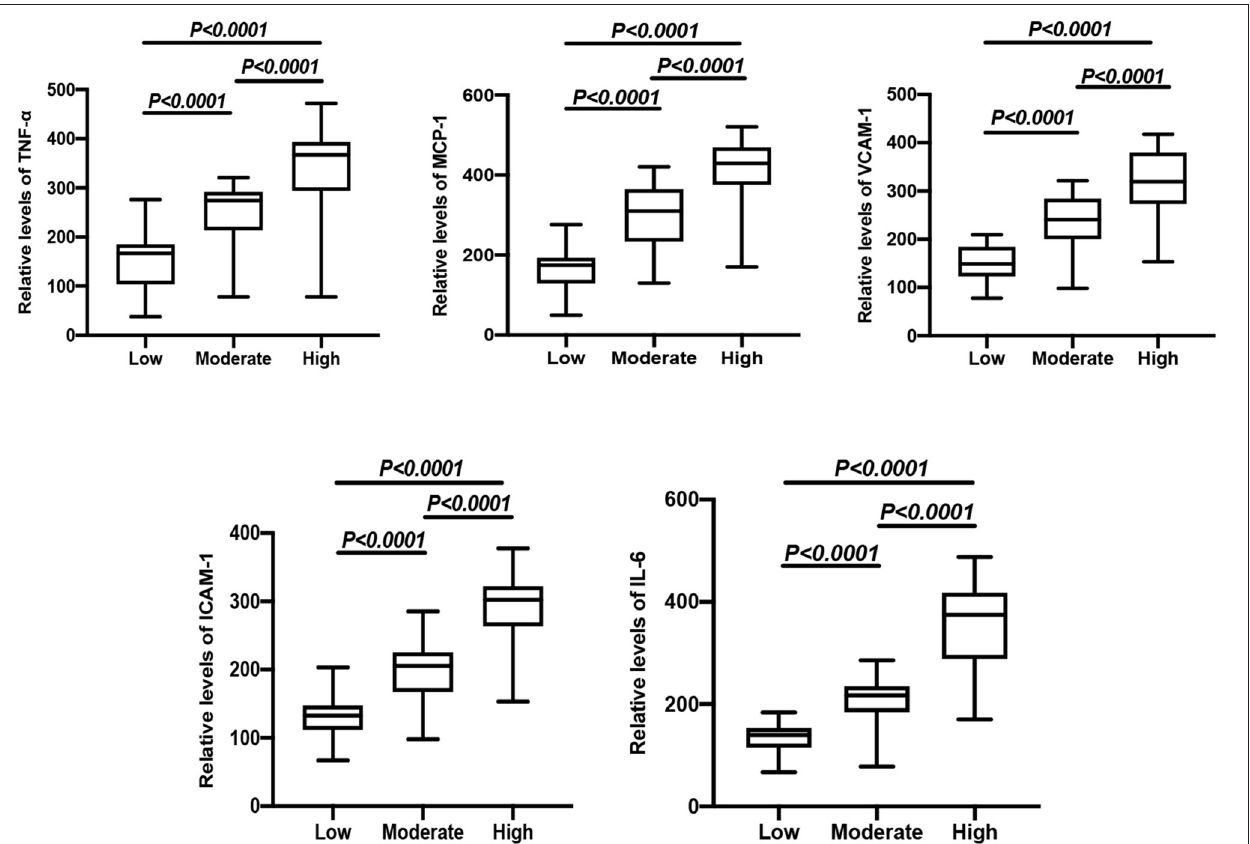
FIGURE 1 | Comparison of relative expressions of TNF- α , MCP-1, VCAM-1, ICAM-1, and IL-6 in the high risk, moderate risk, and low risk groups.